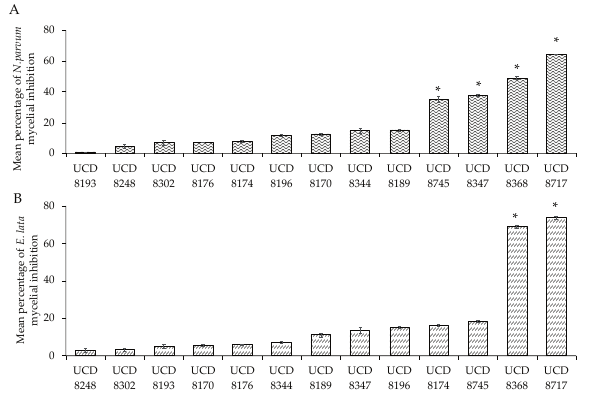
Figure 1. Preliminary in vitro dual culture evaluation of isolated microorganisms’ ability to inhibit radial mycelium growth of the grapevine trunk disease pathogens (A) Neofusicoccum parvum and (B) Eutypa lata. Values are means (± standard errors) of ten repli- cates. * indicates differences compared with experimental controls (Dunnett’s test; P ≤ 0.05).